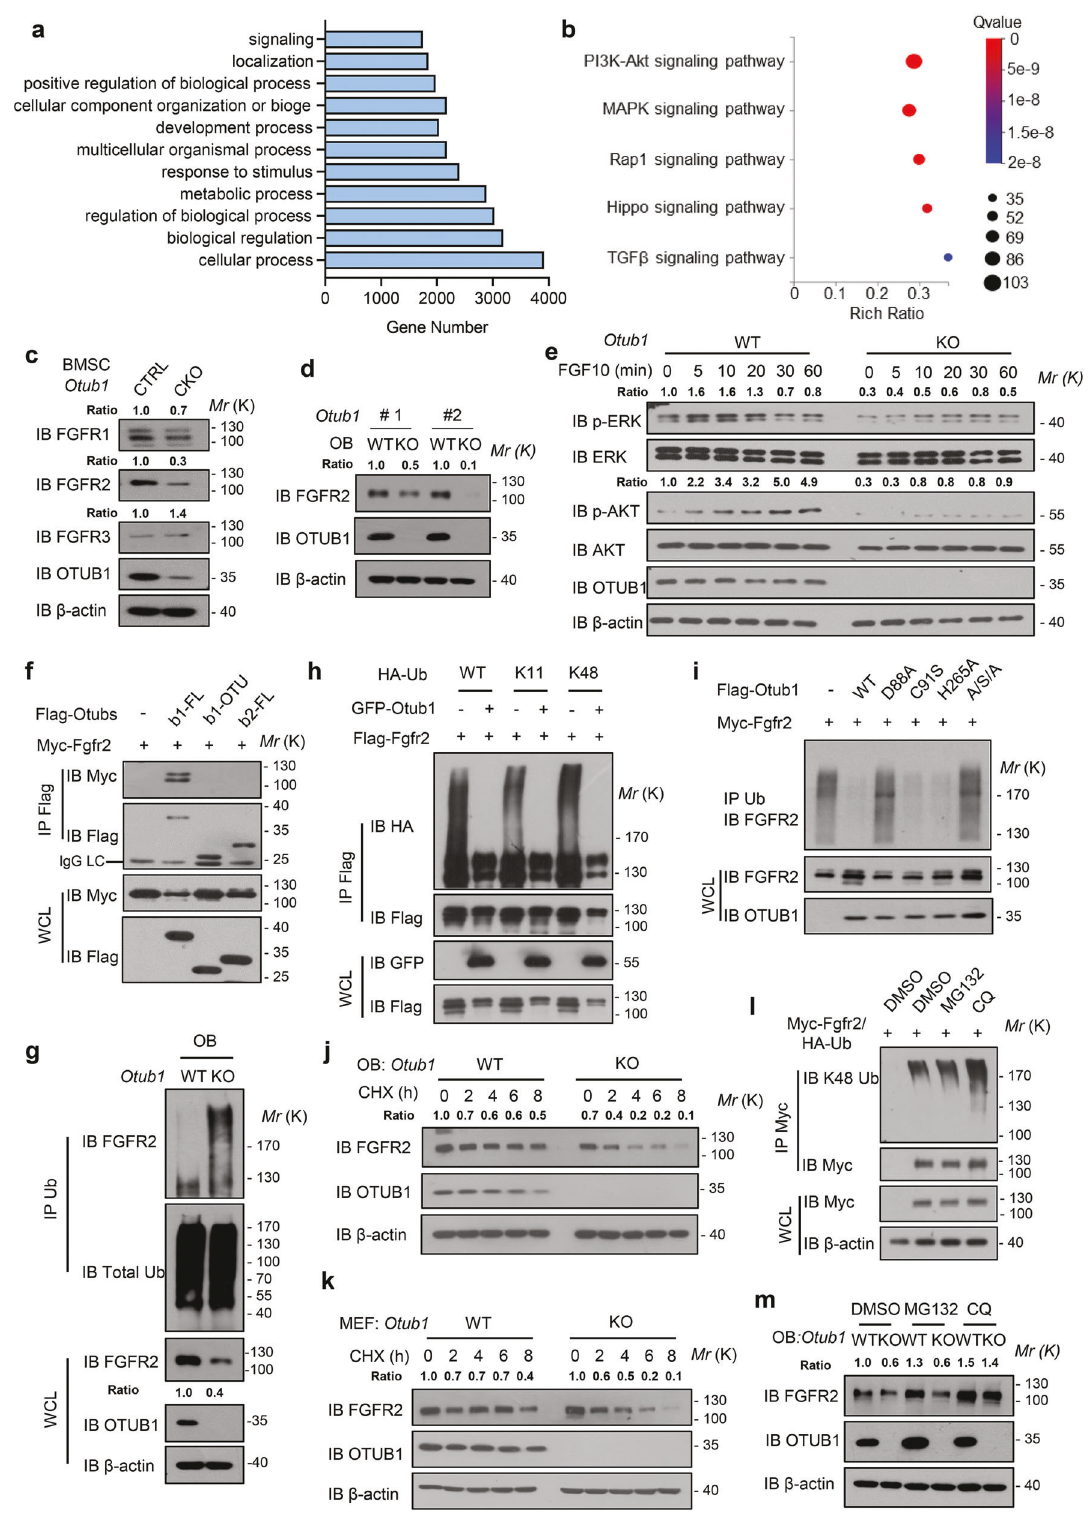
knockout osteoblasts and bones were signi fi cantly increased, whereas the levels in the brain, liver, and spleen remained unchanged (Fig. 4h, i and Supplementary Fig. 4f). Furthermore, the levels of p-ERK and p-AKT upon FGF10 stimulation were increased in Smurf1 knockout cells (Fig. 4j), suggesting that SMURF1 is a Signal Transduction and Targeted Therapy (2023)